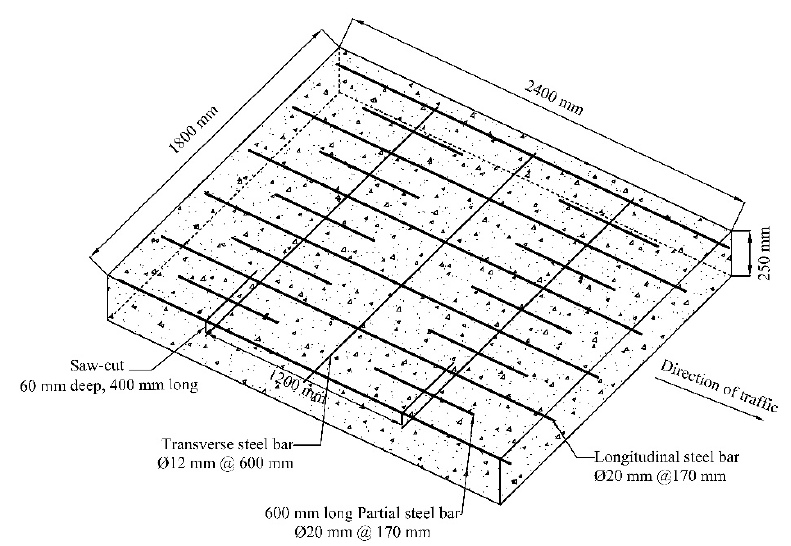
Figure 16. Reinforcement layout of ARCP-1.